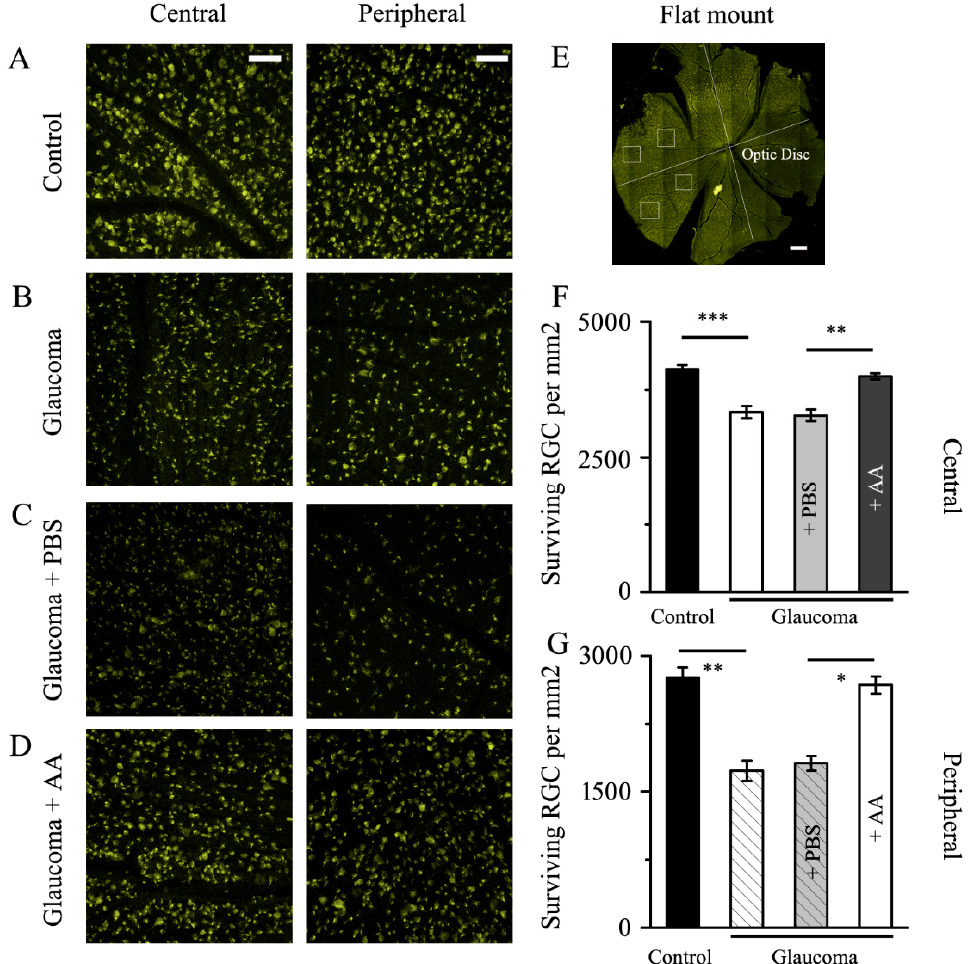
Figure 1. Fluorogold labeling of RGCs in healthy and glaucomatous retinas with and without AA intervention. ( A – D ) Four weeks after the induction of the glaucoma model, Fluorogold labeling of surviving RGCs in flat-mounted retinas. The central (left) and peripheral (right) panels display enlarged retinal images (scale bar, 50 µ m). The control group’s RGC bodies were bright and plump. When compared to PBS ( C ), AA retained cellular integrity and enhanced RGC viability ( D ). ( E ) Whole-mount retina displaying the central and peripheral RGC quantification zones; scale bar, 1 mm. ( F , G ) Analysis of RGC survival in glaucomatous eyes with or without PBS or AA treatment and control eyes using quantitative methods. * p < 0.05, ** p < 0.01, and *** p < 0.001 (one-way analysis of variance).